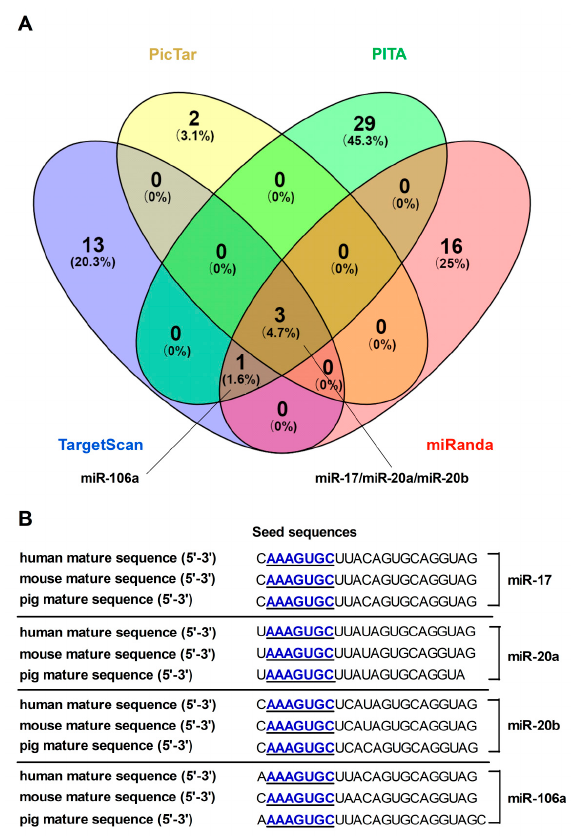
Figure 1. Computational prediction of potential miRNAs target sites on the ferroportin (FPN) 3’untranslated region (3’UTR). ( A ) miRNAs predicted from four different bioinformatic tools were compared using a Venn diagram ( B ) The seed recognition sites of candidate miRNAs are denoted, and all nucleotides in these regions are highly conserved across species.